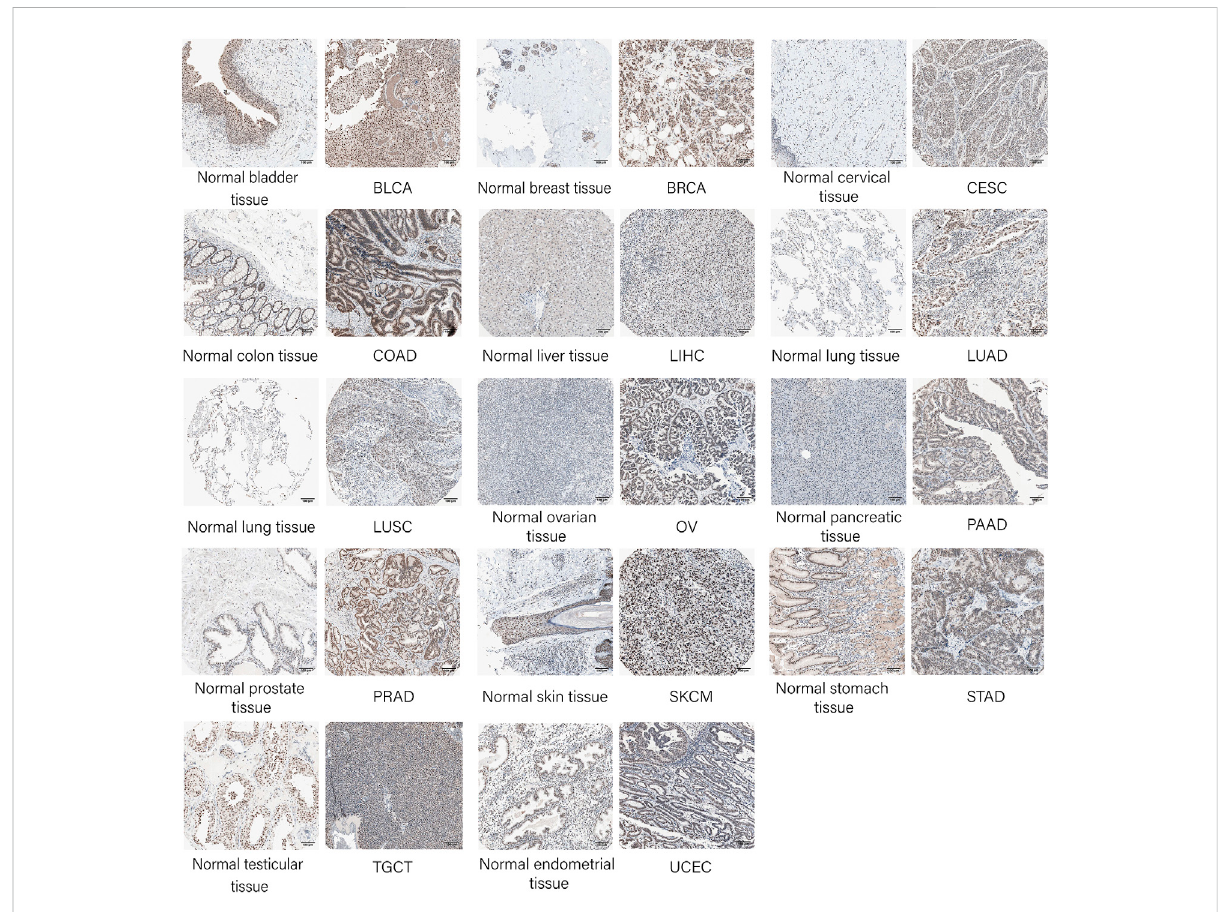
FIGURE 2 Validation of SNRPB protein expression in tumors and the corresponding normal tissues in